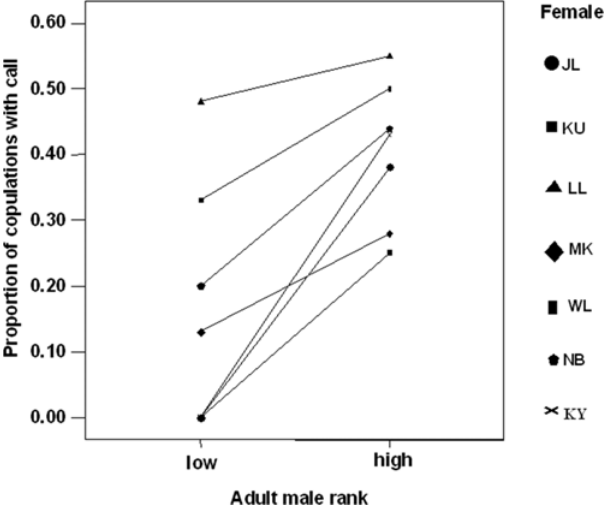
Figure 2. Individual variation in copulation calling behaviour . Line graphs showing the proportion of copulations accompanied by a call when copulating with high (N=5) and low (N=3) ranking males for each of the seven females.